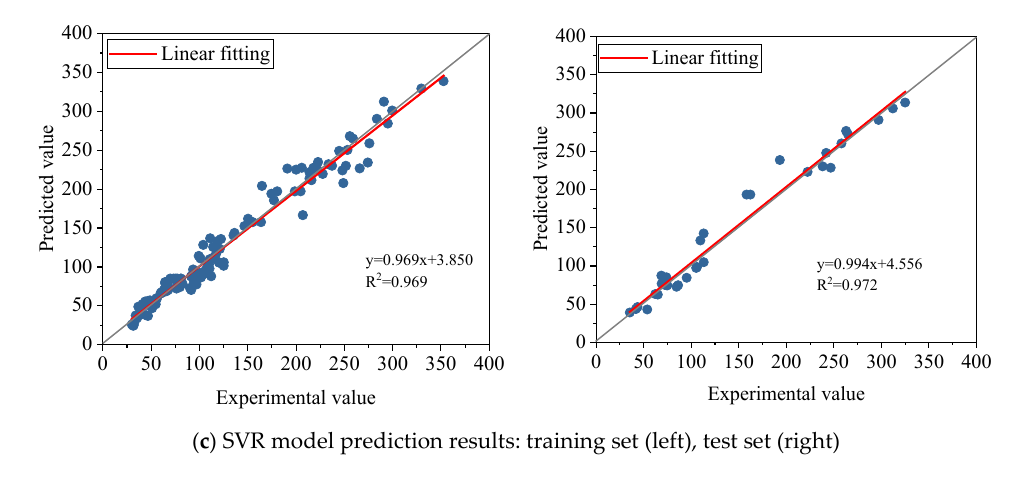
( b ) RF model prediction results: training set (left), test set (right)